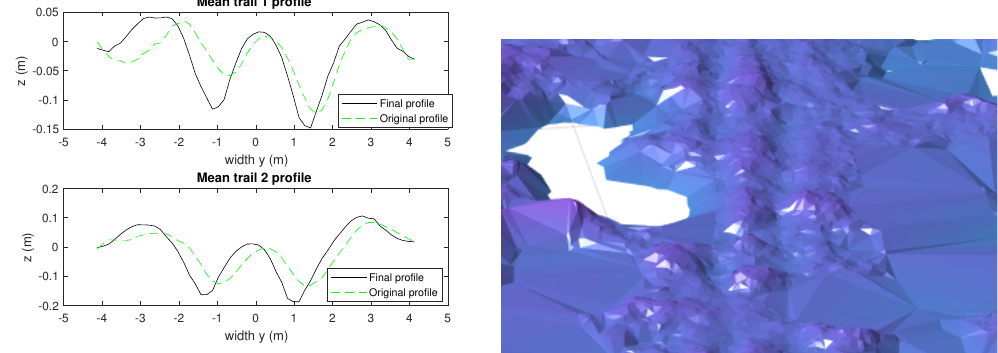
Figure A6. Left : Effect of the profile adjustment to the mean rut profile. Right : The TIN model before the final